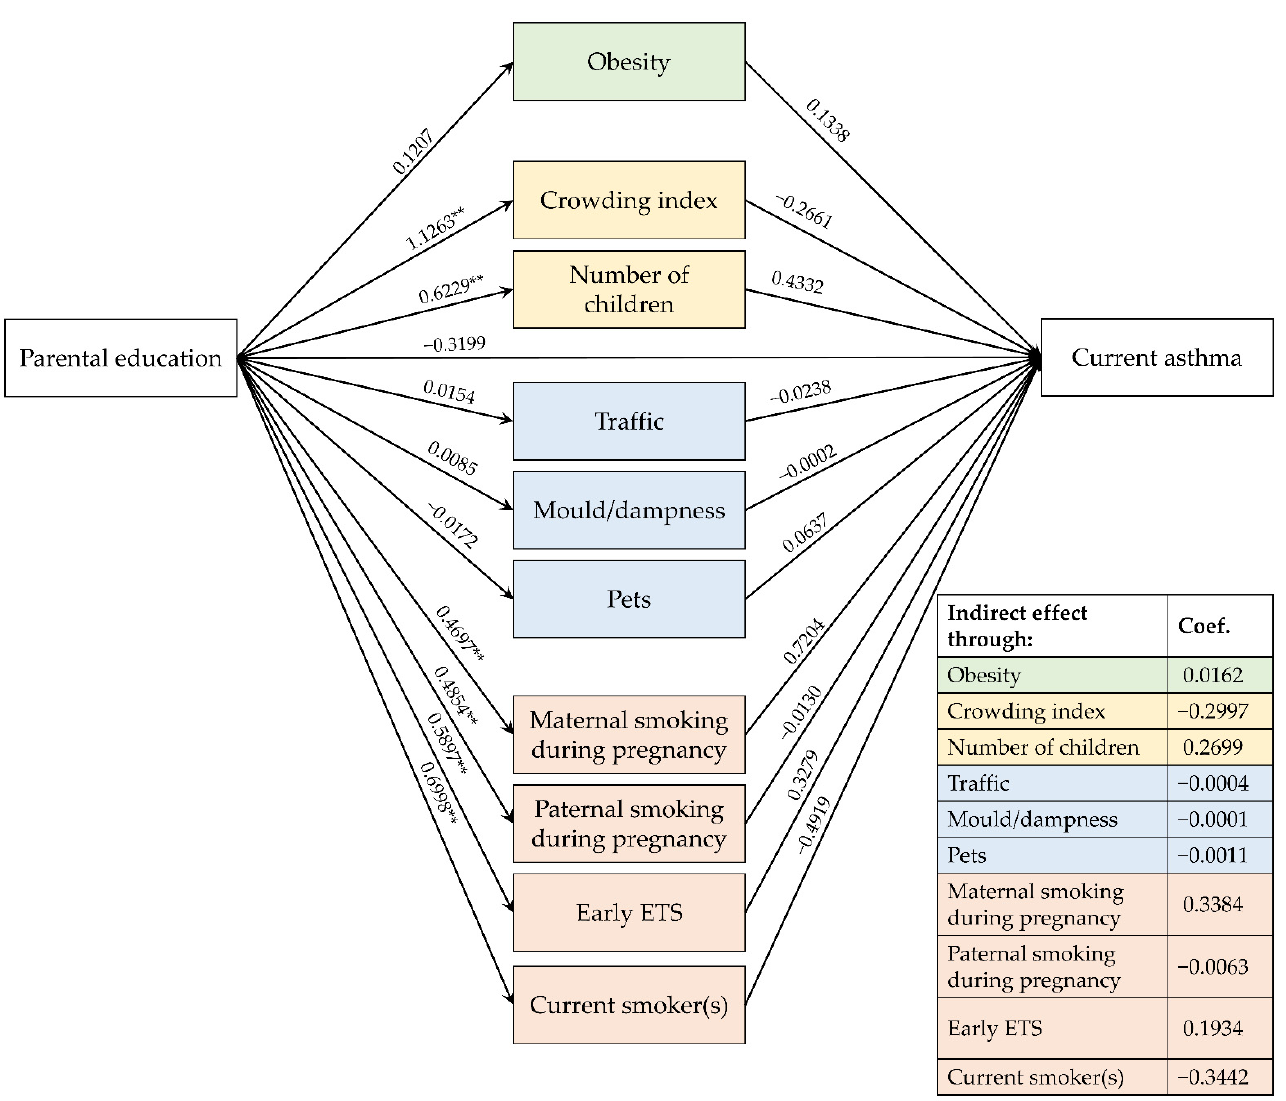
Figure 4. Path diagram of the relationships between parental education, risk factors and current asthma. Note. ETS: environmental tobacco smoke; ** p < 0.01.